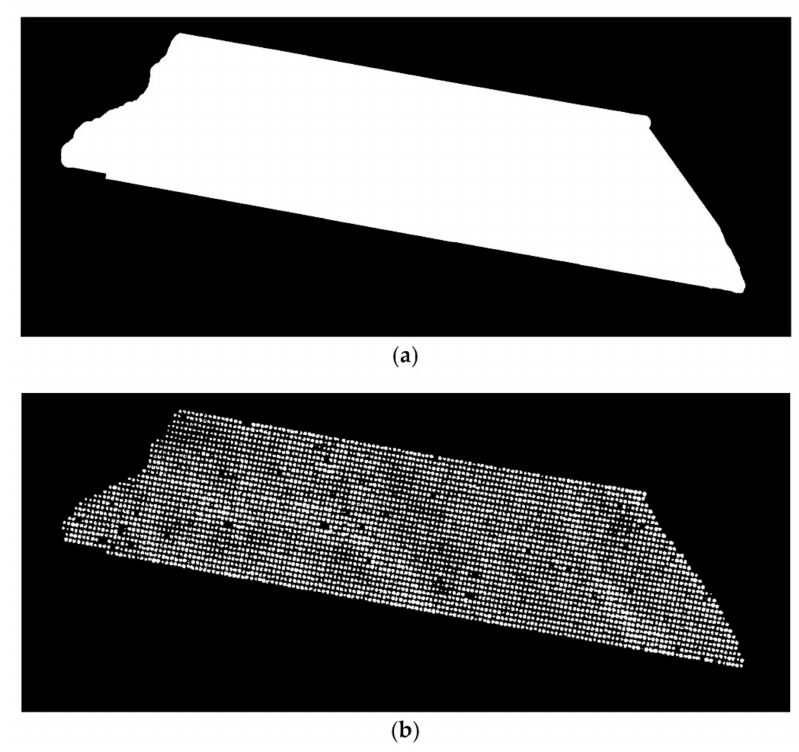
Figure 9. ( a ) ROI mask image I ROI ; ( b ) image I BIN def resulting from filtering the binary image I BIN 3 (visually very similar to I BIN 3 , shown in Figure 8), with image I ROI .